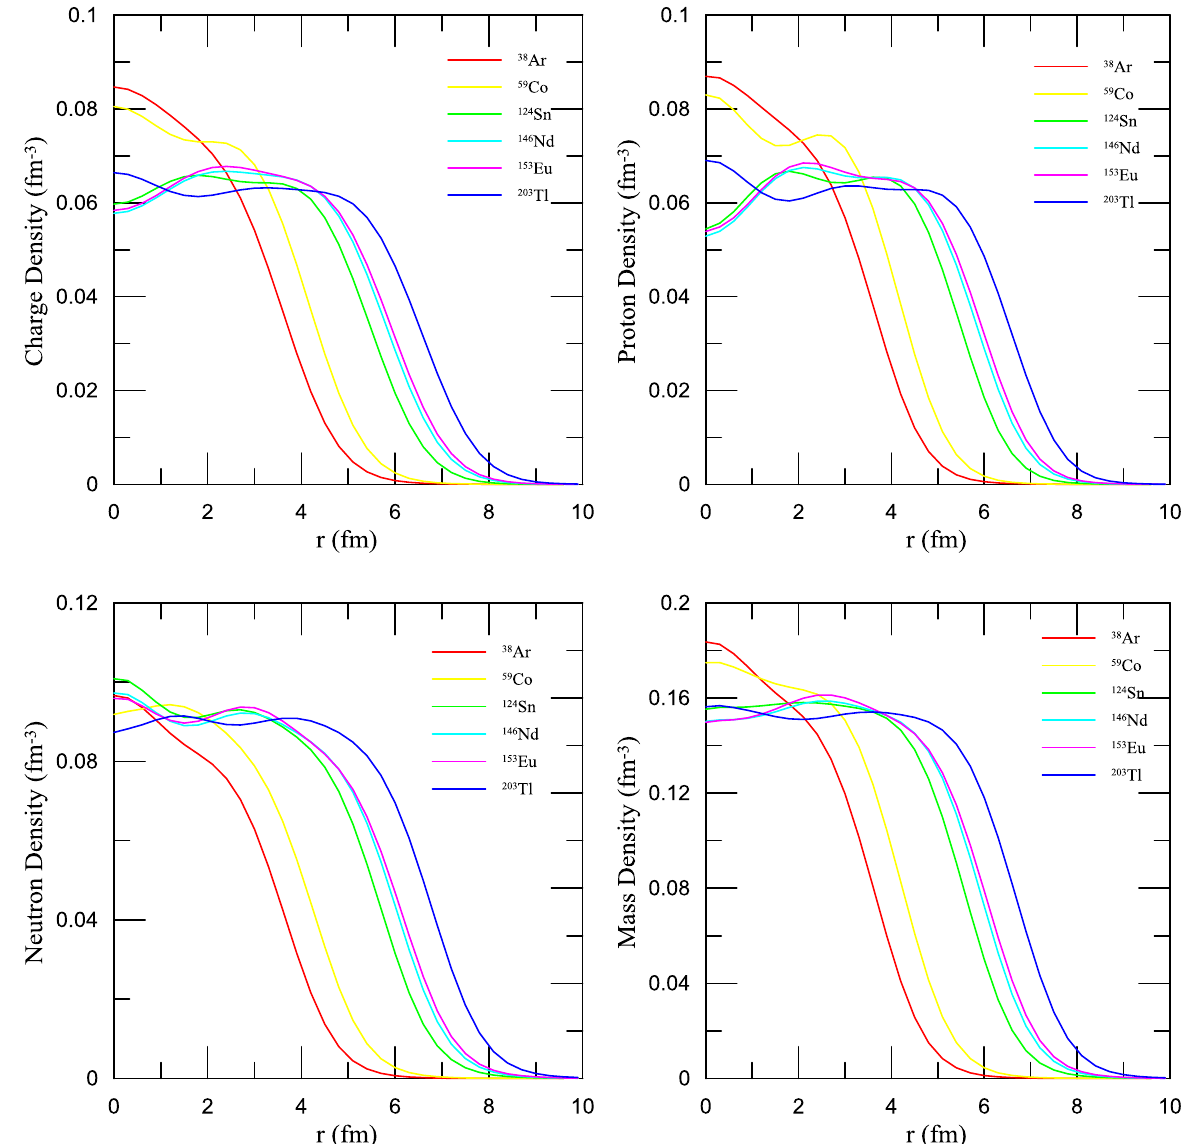
Fig.1: The calculated charge, proton, neutron and mass densities of the selected target nuclei using SkM*